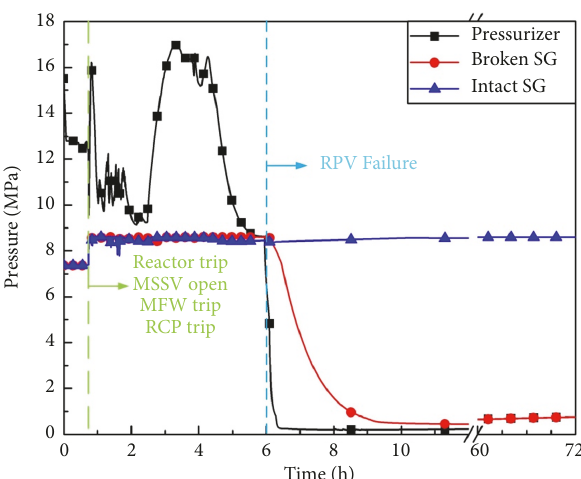
Figure 6: Pressure of the RCS and SGs in the base case.